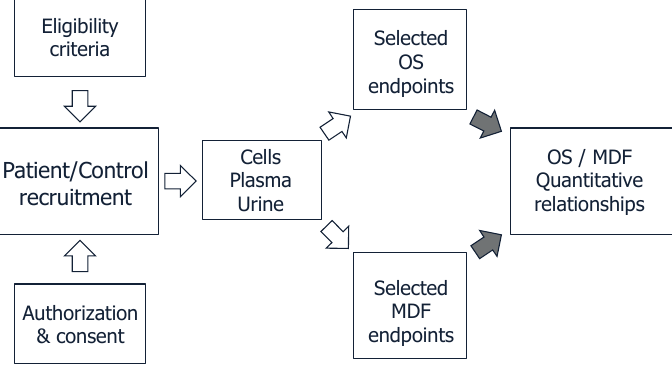
Figure 1. Preliminary database to be achieved in design of mitochondrial nutrients (MN)-based clinical trials.